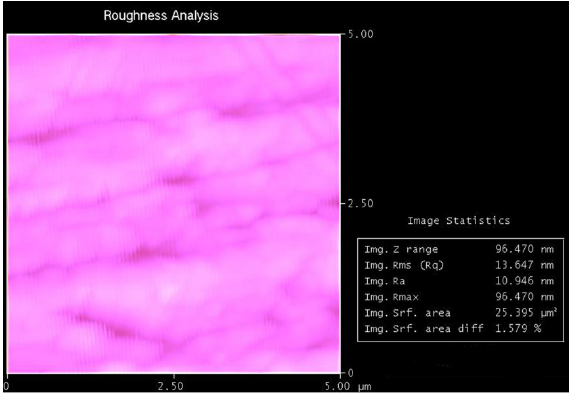
Figure 1. A sample from the roughness analysis of an AFM image taken from the surface of the aluminum specimen.